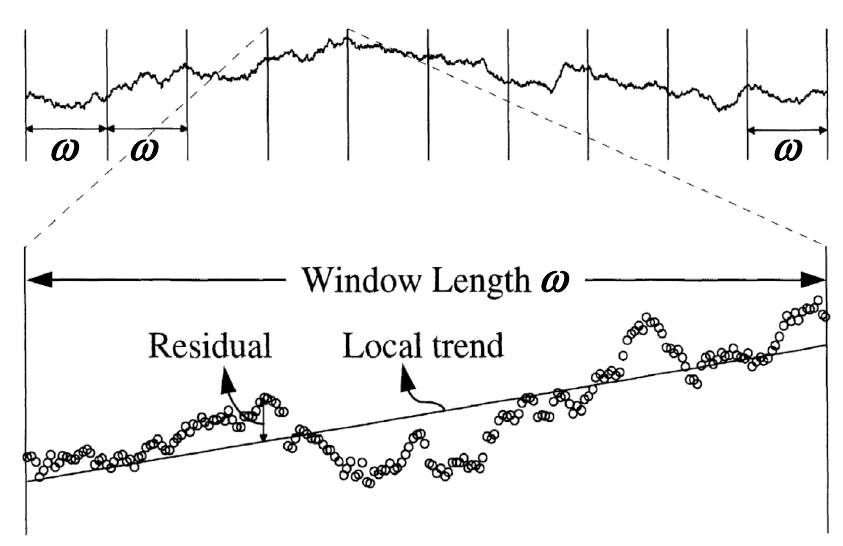
Figure 6. Illustration of the original roughness-length method (after Kulatilake and Um 31 ). ω represents the window